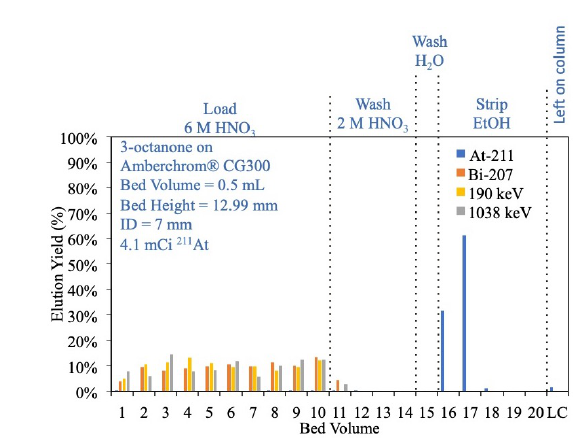
Figure 7. Chromatogram of an aliquot of HNO 3 containing the dissolved bombarded target solution with a 3-octanone impreg- nated Amberchrom ® CG300M resin bed.